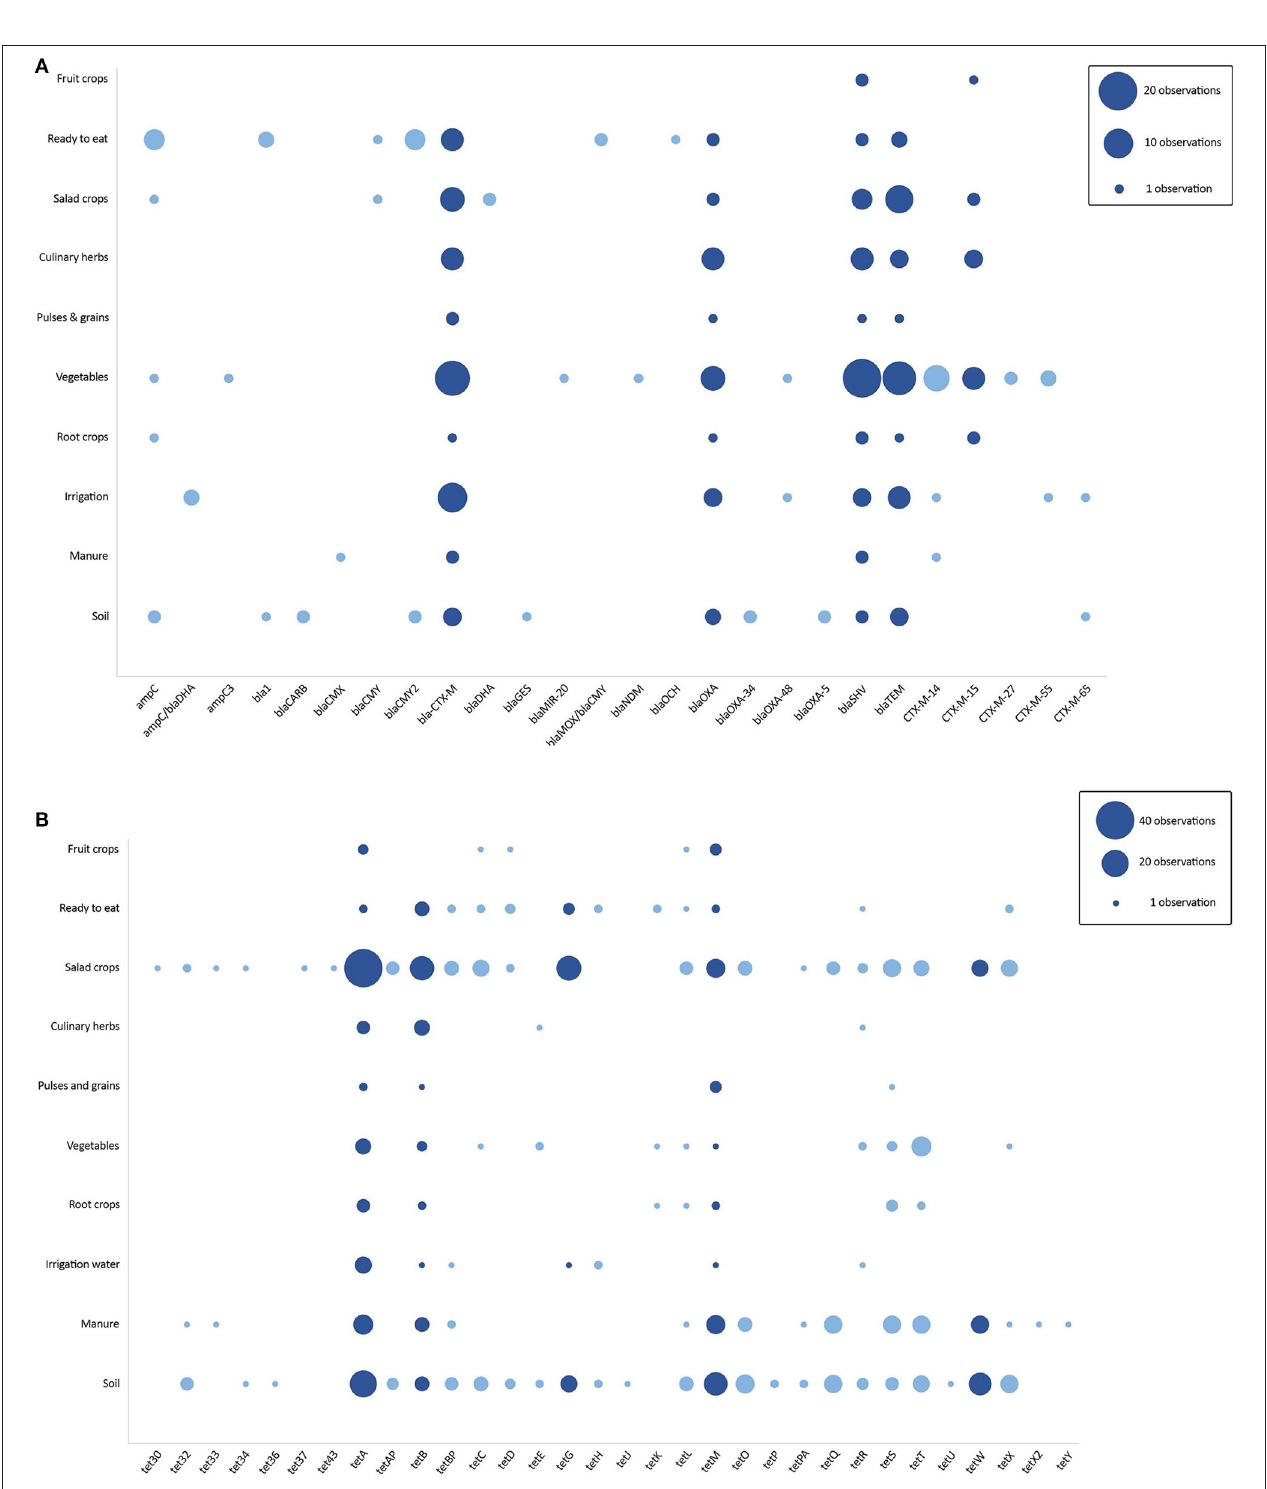
FIGURE 5 | (A,B) Distribution of extended-spectrum beta-lactamase (A) and tetracycline resistance (B) genes across sample groups. Each filled circle corresponds to observations of specific ARG (x-axis) recorded in each sample group (y-axis). The size of the circle is proportional to the number of observations recorded from the study set (studies published between 2000 and 2020). Dark blue shading corresponds to major ARG.